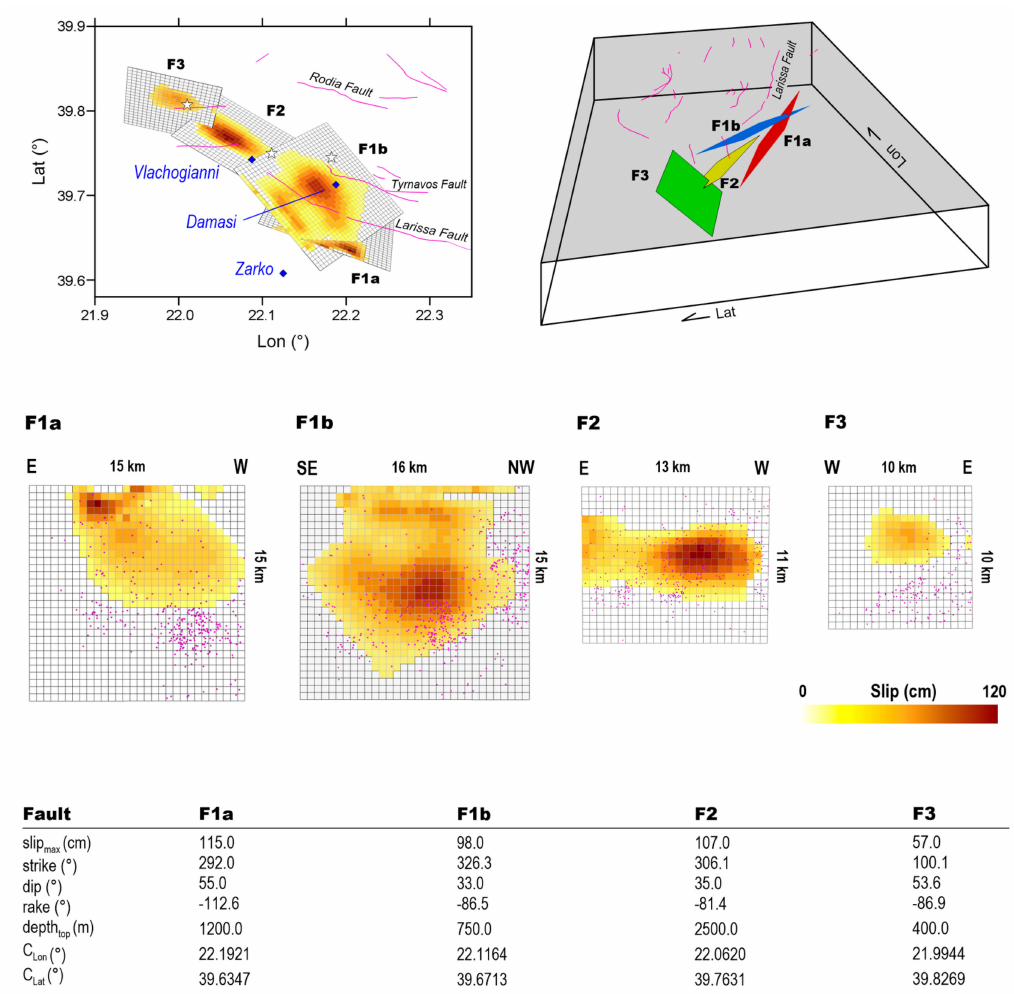
Figure 6. Linear Inversion results. The four sources and relative retrieved parameters of the linear solutions for T3 + T4 in 2-D and 3-D views. Fault lineaments and epicenter of the three largest events are represented by magenta lines and white stars, respectively. The purple points represent all the events occurring on the fault